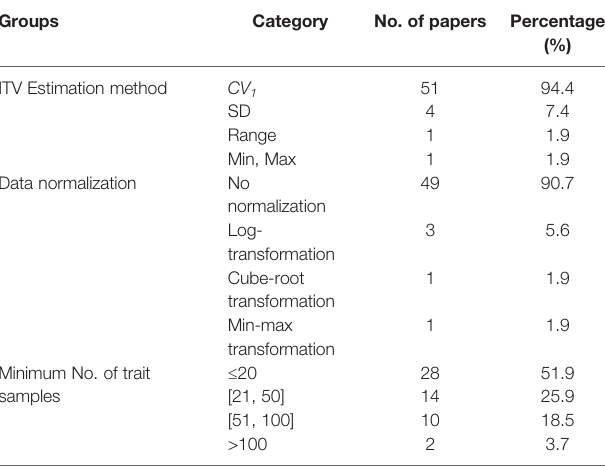
TABLE 1 | A summary of CV estimation methods, data normalizations and the minimum number of samples for each species used in conventional studies.